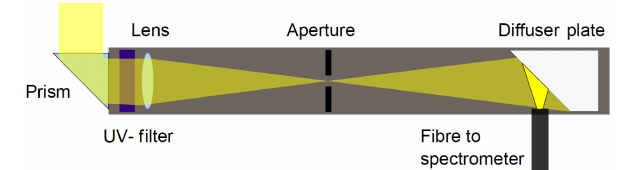
Figure 3. Sketch of the telescope used to feed sunlight into the UV spectrometer. The telescope was mounted into the outer part of solar light beam collected by the solar tracker. A prism feeds sunlight into the telescope (0.5in. tube diameter, ∼ 120mm tube length), which consists of a UV filter (Hoya U330), a lens (fo- cal length f = 40mm), and a circular aperture (800µm diameter) aligned to the focus of the lens. A polytetrafluoroethylene (PTFE) diffuser plate illuminates the glass fiber (400µm diameter), which then guides the sunlight into the UV